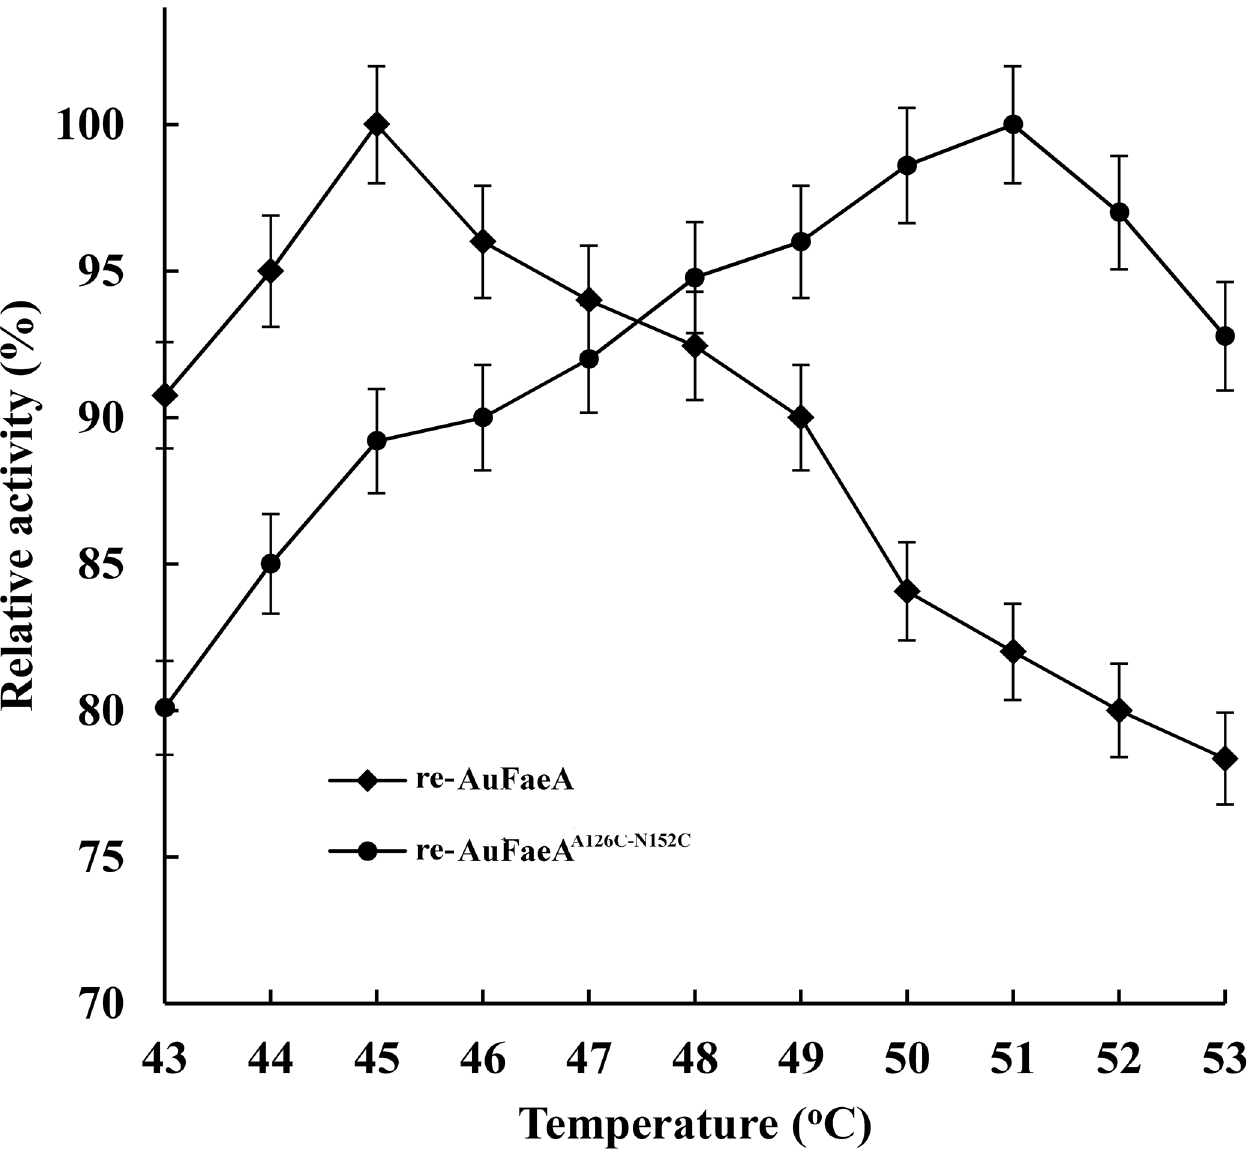
Fig 5. Temperature optima of the re-AuFaeA and re-AuFaeA A126C-N152C . The temperature optima were measured under the standard assay conditions, with variable temperatures ranging from 43 to